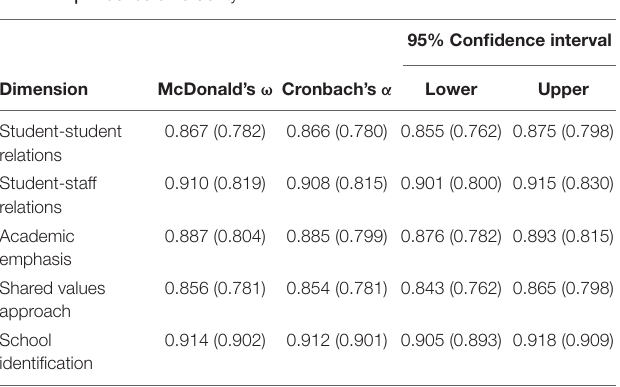
TABLE 2 | Evidence of